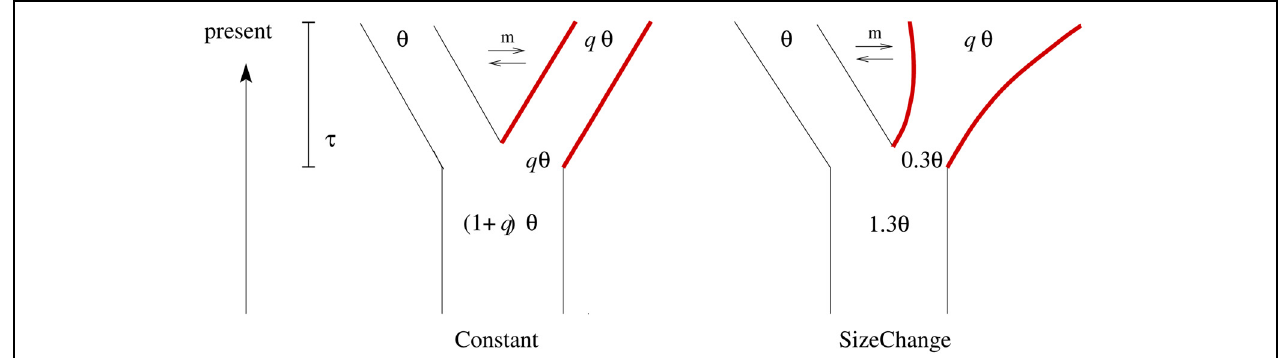
FIGURE 1 | In both demographic models used for the simulation study – Constant and SizeChange – one ancestral population splits into two daughter populations at time τ followed by continuous, bidirectional gene flow. Selection is simulated by introducing a single selected site at the time of the split in the second population only (marked in red; for more details see